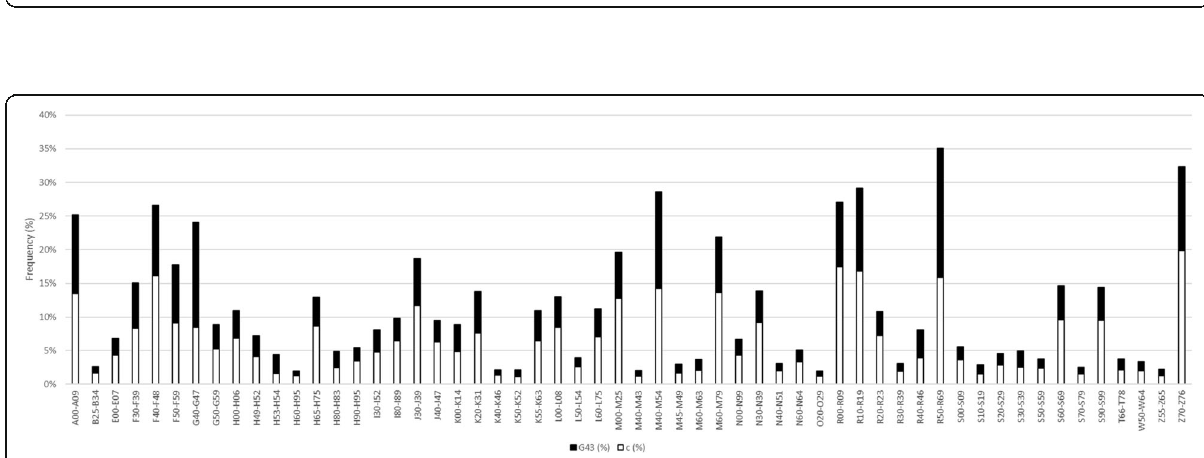
Fig. 5 The frequency of diagnoses with > 20% prevalence in the migraine patients. J06 Acute upper respiratory infections of multiple and unspecified sites, M54Dorsalgia, J01 Acute sinusitis, M53 Other dorsopathies, J20 Acute bronchitis, R10 Abdominal and pelvic pain, A09 Diarrhoea and gastroenteritis of presumed infectious origin, M79 Other soft tissue disorders, Z76 Persons encountering health services in other circumstances